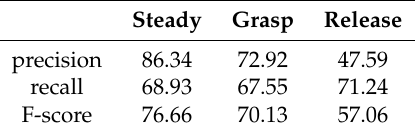
Table 3. Accuracy measures for a 5-component unigram HMM. All values are